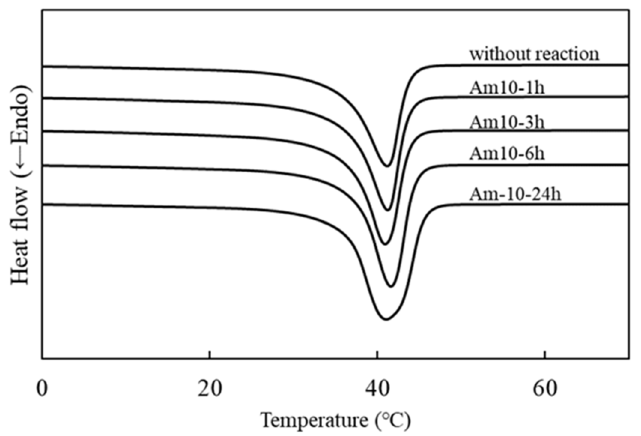
Figure 6. DSC charts of the samples before and after reaction with DMEDA. Symbols of samples are indicated in Table 2.